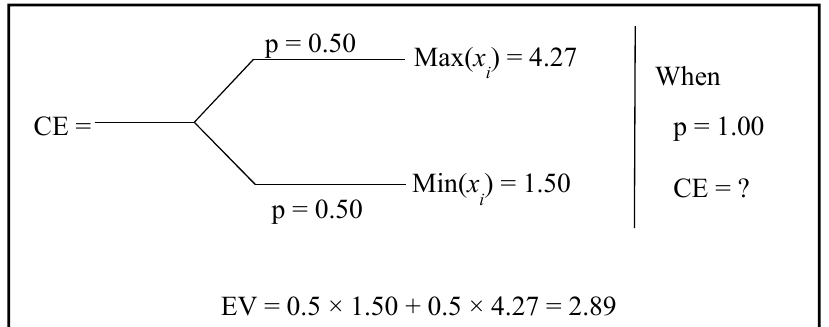
Figure 6. Lottery setup to discern utility values for the benefit of reliability.